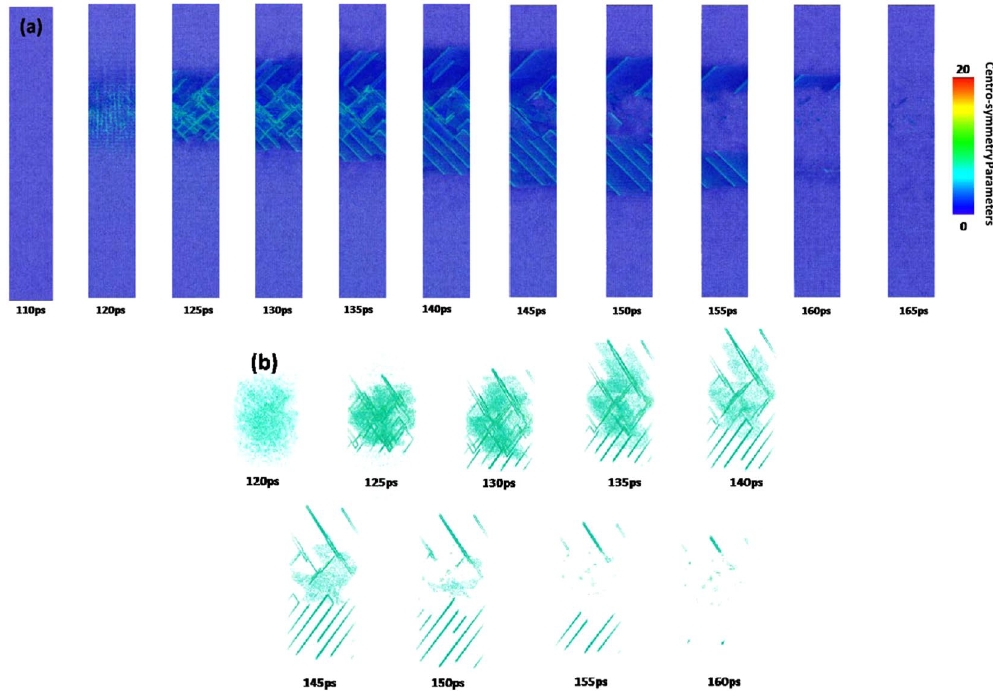
Figure 11. Snapshots of atomic configuration in the 350–450 nm part of 450 nm 〈 100 〉 copper film under an absorbed laser intensity of 0.065 J/cm 2 at 110–165 ps time instant. The atoms are colored according to their centro-symmetry parameters, ( a ) 0 < CSP < 20, ( b ) CSP >